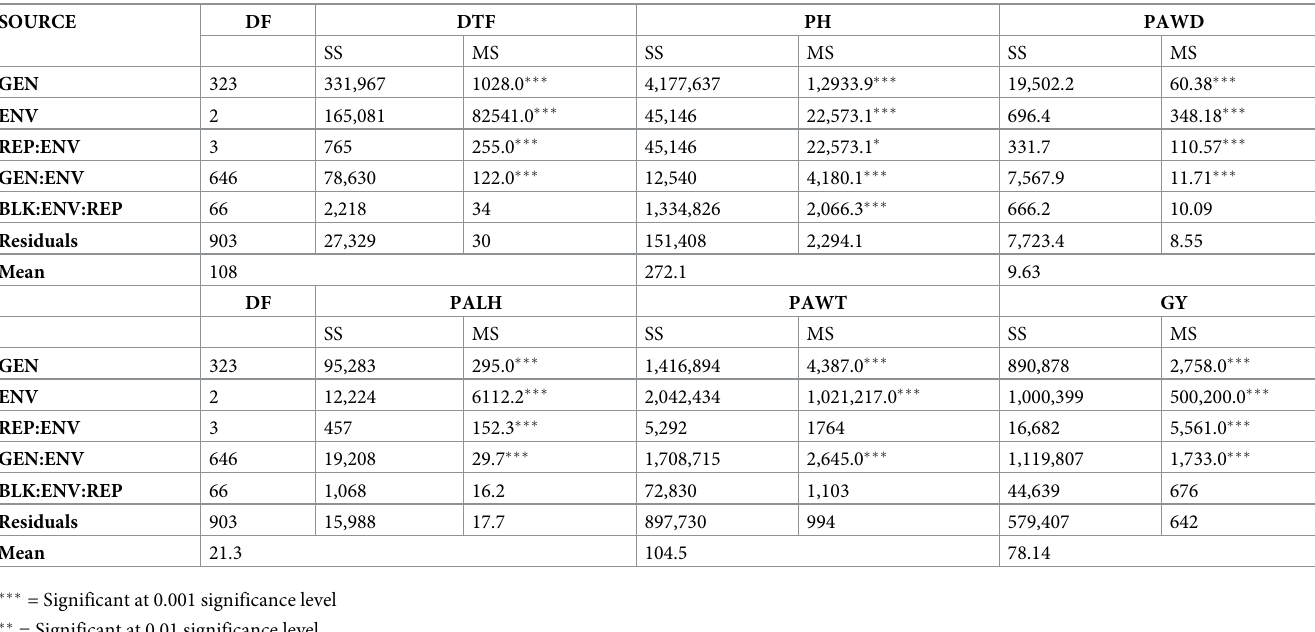
Table 2. Combined analysis of variance for grain yield and related traits of 324 sorghum genotypes across three